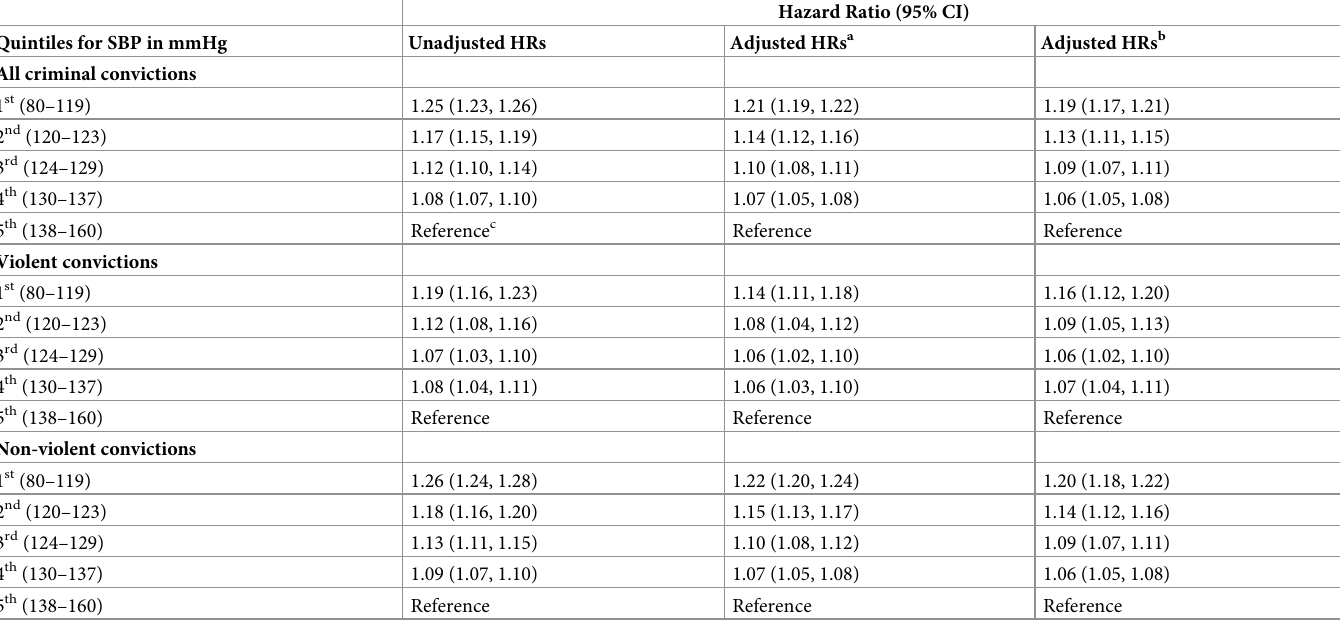
Table 3. Cox proportional hazard regression models for systolic blood pressure with